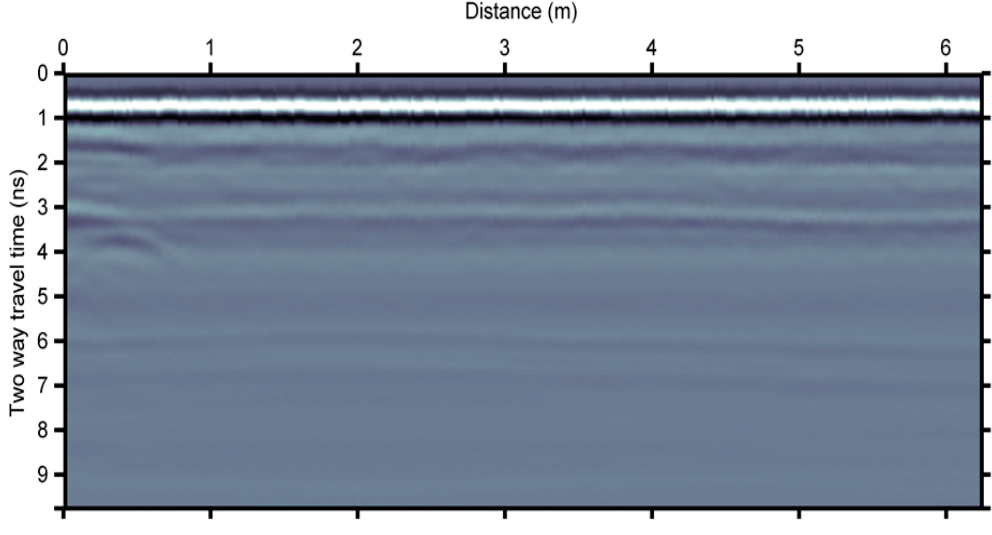
Figure 6. The GPR section after the application of a de-wow filter.